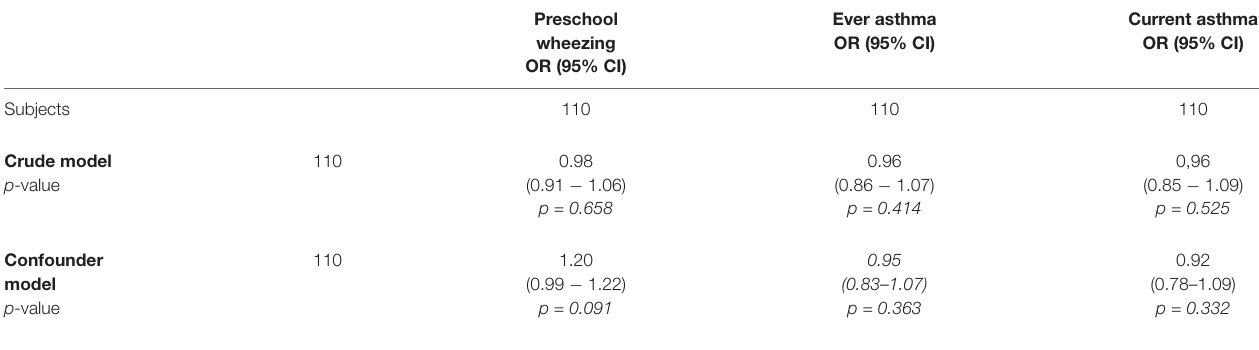
TABLE 3 | Association of breastfeeding duration with preschool wheezing and asthma.